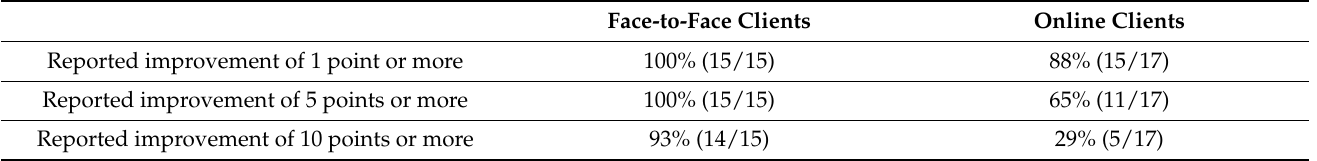
Table 3. Reported improvements for face-to-face and online clients for Outcome 1: Mental